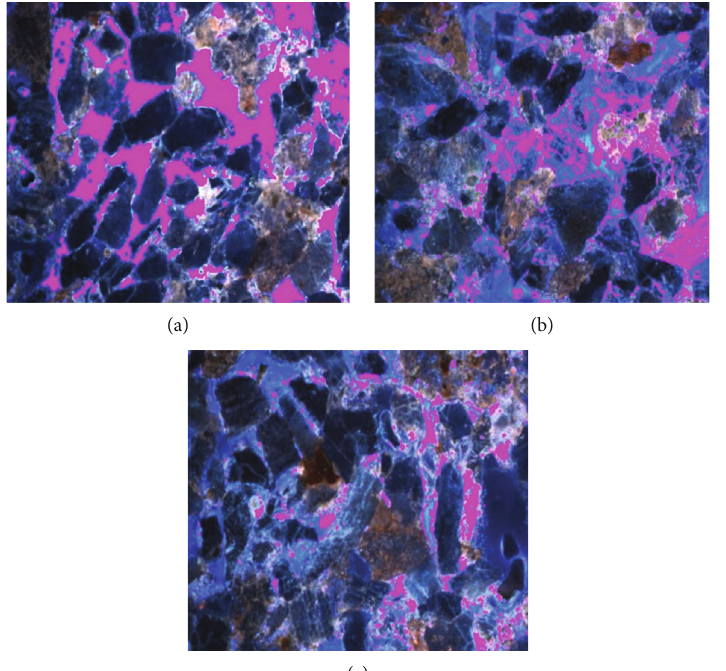
Figure 12: Fluorescence analysis results after di ff erent displacement methods (the pink mark is residual oil). (a) Water fl ooding. (b) Polymer fl ooding. (c) ASP fl